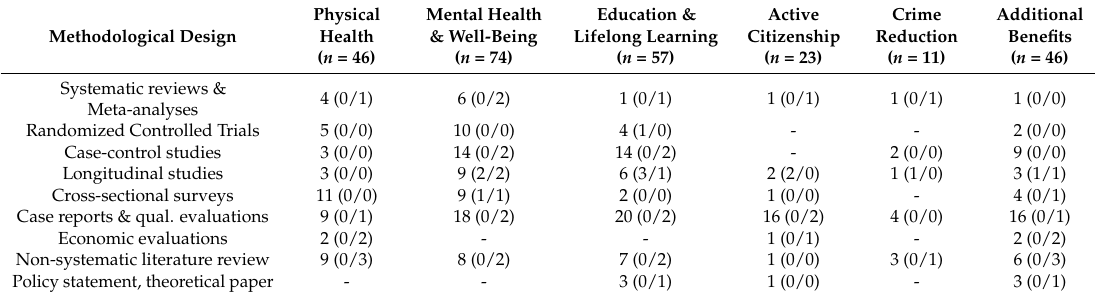
Table 3. Design of evidence per benefit 1